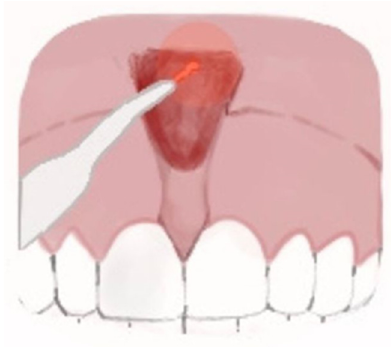
Figure 5. Laser Figure 5. Laser frenectomy.